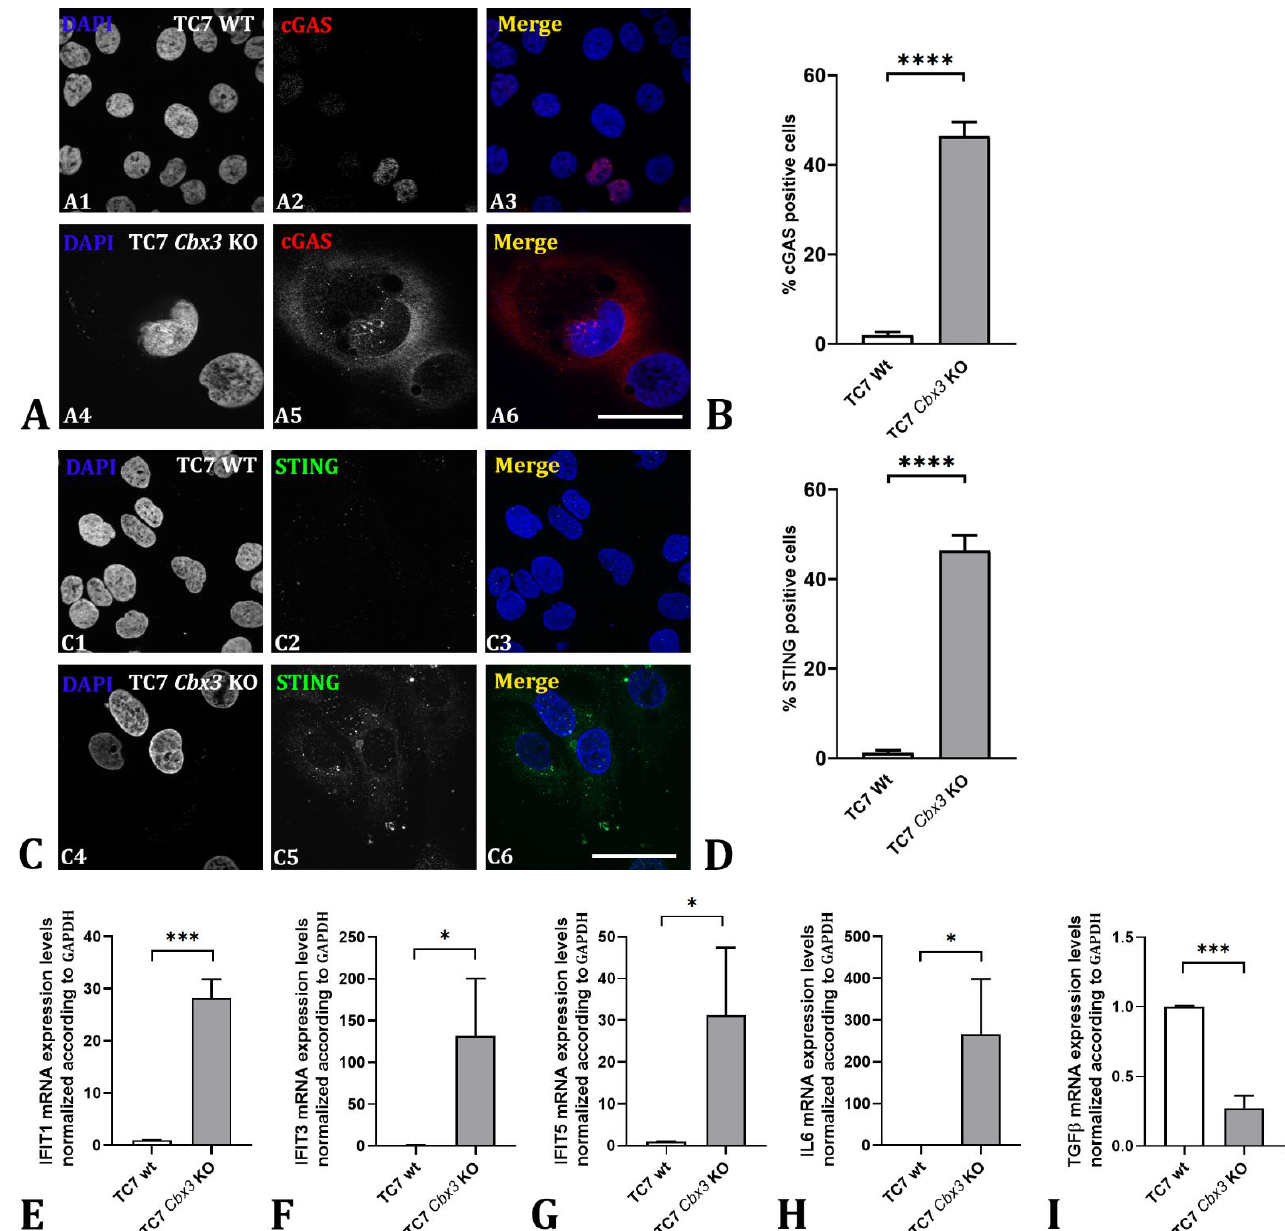
Figure 6. Analysis of the c - GAS - inflammatory response upon depletion of HP1γ in TC7 cells: ( A ) Detection of cGAS by immunofluorescence microscopy: the cGAS signal was weakly visible in TC7 WT cells ( A1 – A3 ), and localized in the cell nucleus, whereas expression is triggered in TC7 Cbx3 KO cells and principally detected in the cytoplasm ( A4 – A6 ). ( B ) Quantitative analysis of the number of cGAS positive cells. ( C ) STING detection by immunofluorescence microscopy: STING protein remains at undetectable levels, based on our parameters in TC7 WT cells ( C1 – C3 ), while in TC7 Cbx3 KO cells ( C4 – C6 ), its presence in the cytoplasm was markedly induced. ( D ) Quantitative analysis of the number of STING positive cells. ( E – I ) Q - PCR analysis of the corresponding genes associated with the inflammatory response. n = 3 clones per condition (generated by 1 sgRNA), 3 plates per clone (different plates were analyzed together). Values are mean ± SD. * p < 0.05; *** p < 0.001; **** p < 0.0001 ( t - test and non - parametric, two - tailed p value). Scale bar: 50 µm. The uncontrolled activation of inflammatory pathways is a critical event in